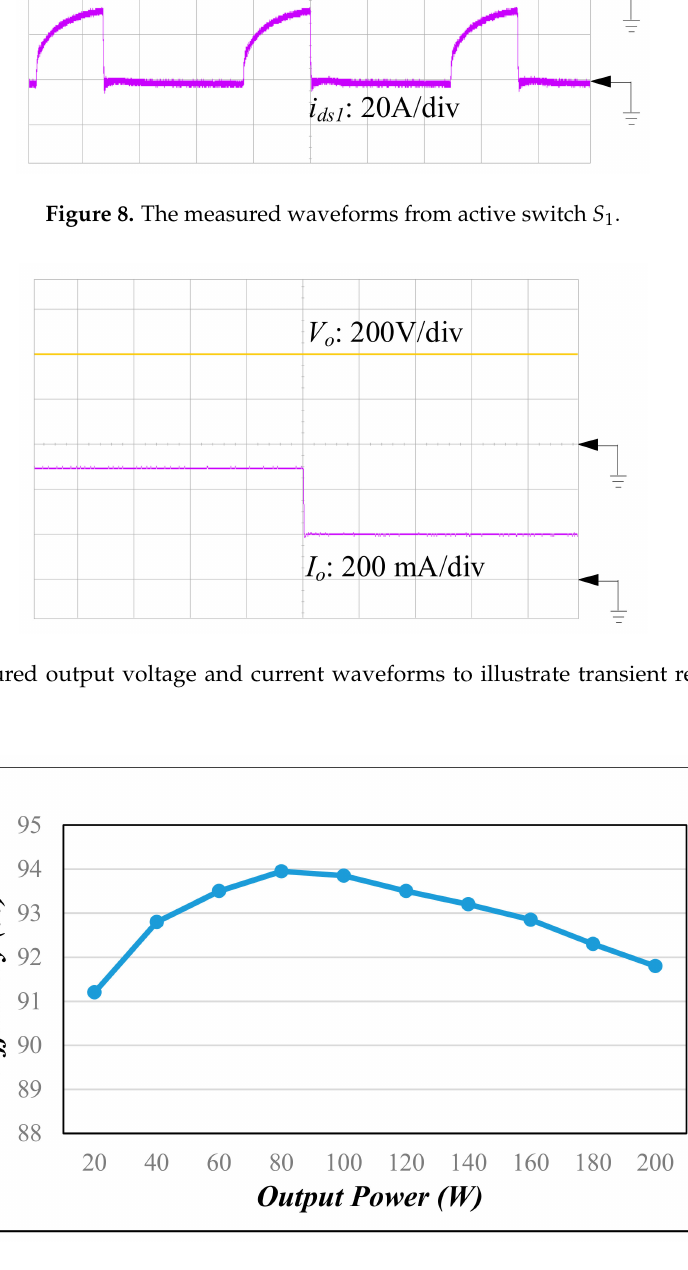
Figure 10. The measured efficiency of the proposed